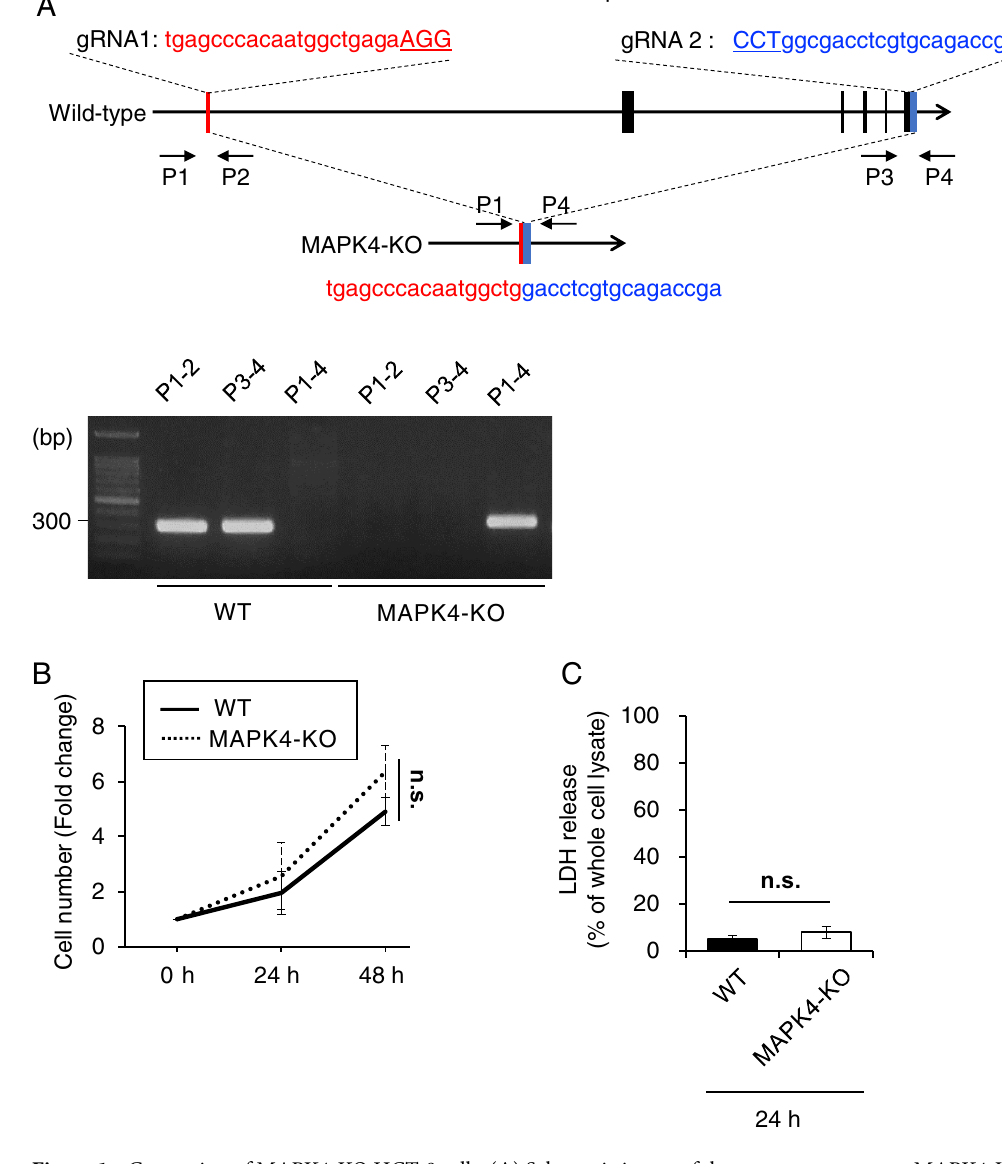
Figure 1. Generation of MAPK4-KO HCT-8 cells. ( A ) Schematic image of the strategy to generate MAPK4-KO HCT-8 cells and genotyping. Two gRNAs were designed to hybridize and eliminate the MAPK4-coding site in HCT-8 cells. Genomic DNA of each cell was extracted and analyzed by PCR analysis. PCR of P1-4 site was not amplified with WT HCT-8 cells because of long introns in-between. The sequence of the P1-4 product in MAPK4-KO HCT-8 cells is shown in the image. ( B ) Cell growth assay of WT and MAPK4-KO HCT-8 cells. No significant difference was observed with cell types (Two-way ANOVA, p = 0.1316). ( C ) LDH-based cell mortality of WT and MAPK4-KO HCT-8 cells under non-infected conditions. Percentages represent the ratio of LDH release to whole cell lysates. No significant difference was observed (Student’s t test, p = 0.1393). All graphs show the mean ± SEM for more than three independent experiments. All images are representative of three independent